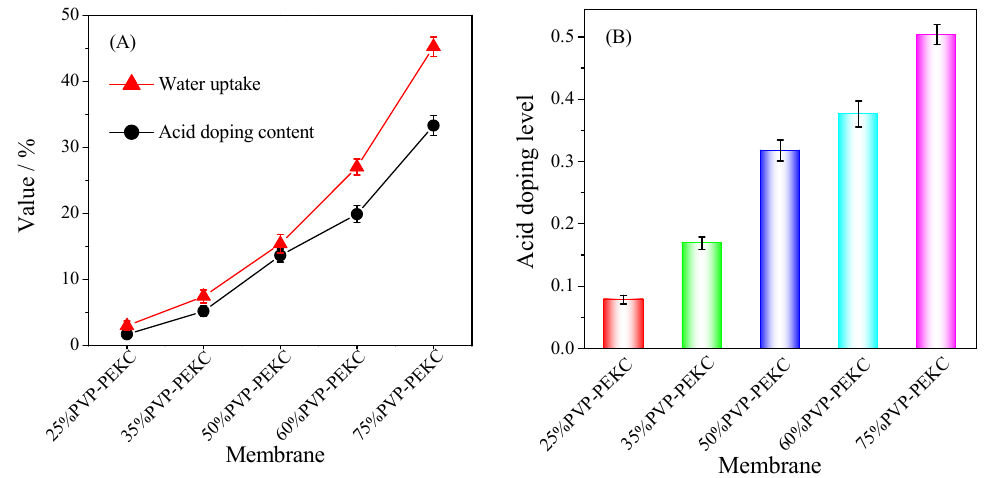
Figure 4. Water uptake, acid doping content ( A ), and acid doping level ( B ) of various blend mem- branes after submersing in 3 M H 2 SO 4 solution at RT.